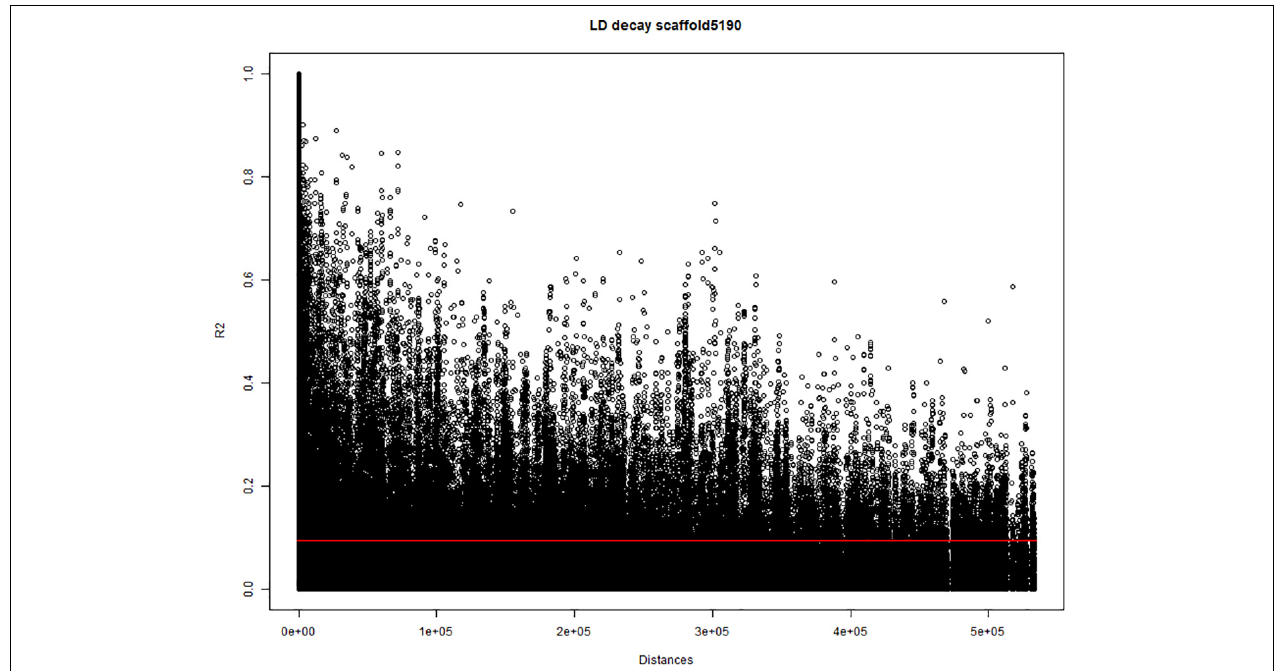
FIGURE 1 | Estimation of the linkage disequilibrium (LD) decay of the largest scaffold (scaffold5190; 565.9 kbp) covered with single nucleotide polymorphism (SNP) markers. The X -axis indicates the physical distances and the Y -axis indicates the pairwise correlations ( r 2 ) between all pairs of markers from the scaffold. Red line indicates the critical value of r 2